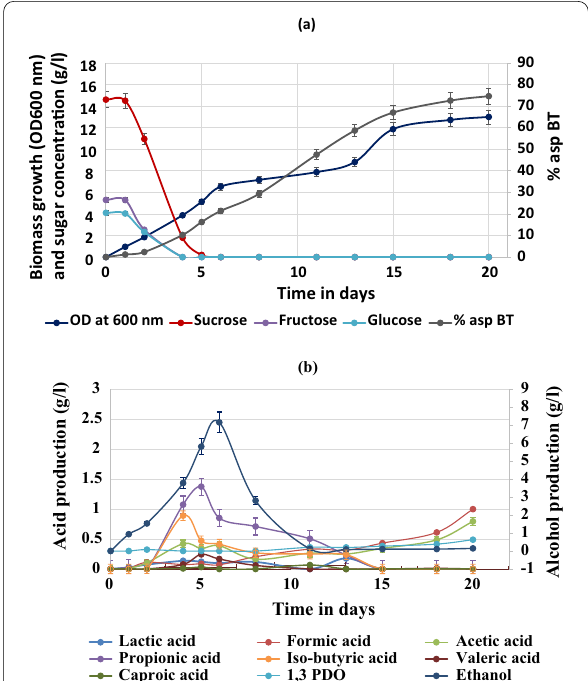
Fig. 4 Kinetics of asphaltene biotransformation by growing cell consortium in a 1.5 l bioreactor using sucrose as a primary carbon source. a Biomass growth, sugar uptake and percentage asphaltene biotransformation profile. b Ethanol and acid formation profile during asphaltene biotransformation